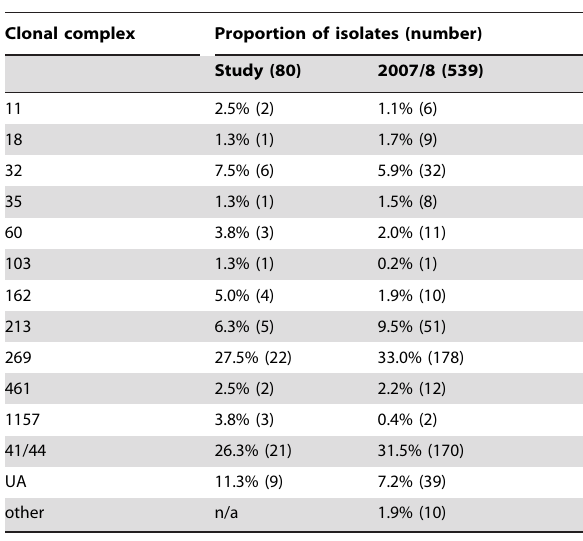
Table 1. Comparison of the clonal complex distribution of the study isolates and all English, Welsh and Northern Irish serogroup B invasive meningococcal disease isolates for the epidemiological year